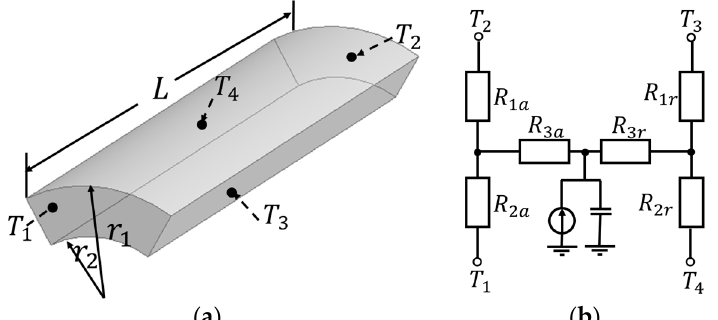
Figure 14. The 3D LPTN model for the stator for the modular machine. ( a ) Heat convection block. ( b ) Heat conduction block. FG is the flux gap.